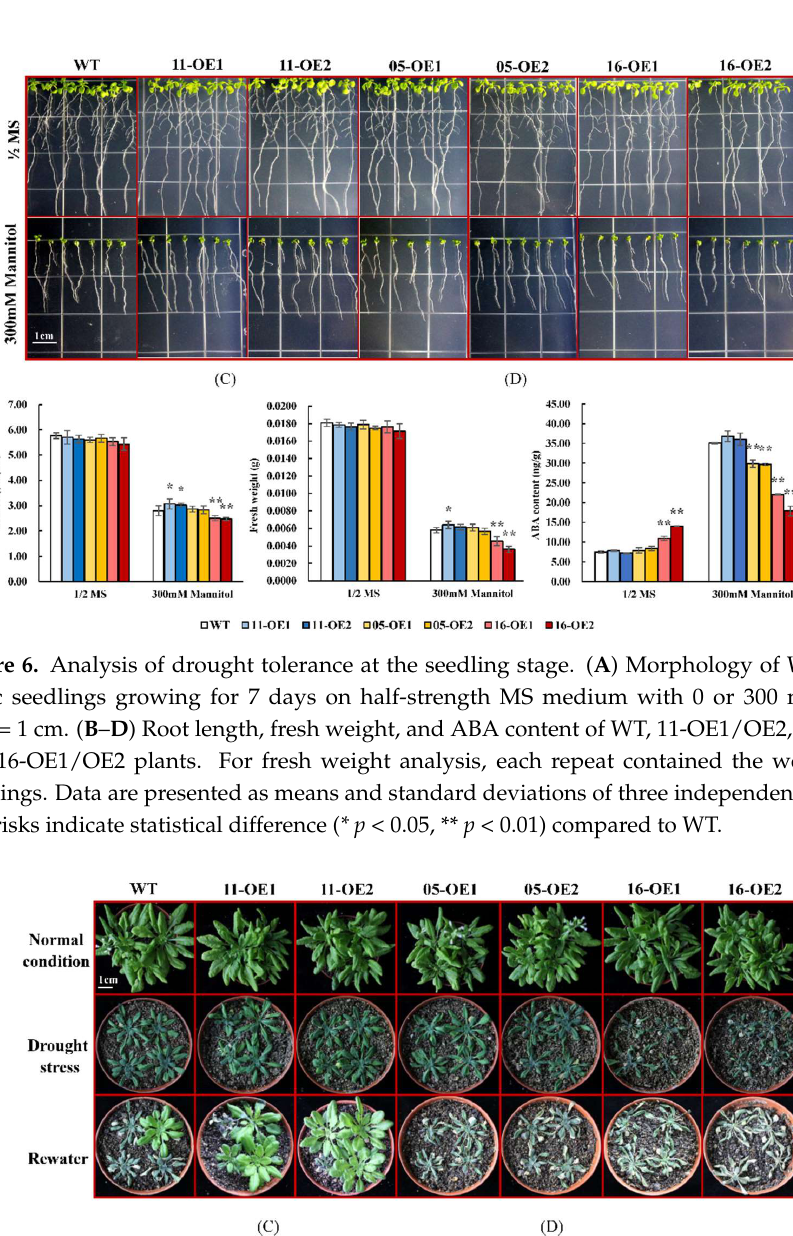
Figure 5. Analysis of drought tolerance at seed germination stage. ( A ) Morphology of WT and transgenic seeds germinated for 8 days on half-strength MS medium with 0, 300, or 400 mM man- nitol. Below, the distribution diagram for the WT and transgenic lines on the culture plate is shown. Bars = 1 cm. ( B ) Root length of 8 day old WT, 11-OE1/OE2, 05-OE1/OE2, and 16-OE1/OE2 plants. Data are presented as means and standard deviations of three independent experiments. Asterisks indicate statistical difference (* p < 0.05, ** p < 0.01) compared to WT.